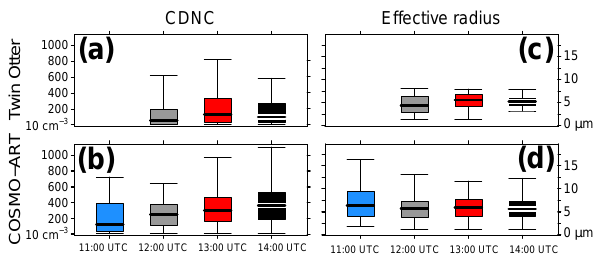
Figure 4. Box plots of (a, b) the CDNC (cm − 3 ) and (c, d) the cloud droplet effective radius (µm) according to the flight track denoted in Fig. 3a for (a, c) Twin Otter observations and the (b, d) COSMO- ART reference case. The flight track is separated into hourly time steps from 11:00 to 14:00UTC as highlighted by the colors (com- pare to Fig. 3). In (a, c) the observations according to the flight track section with 1s temporal resolution of the CDP device are used. In (b, d) the simulation results of the cube that is spanned horizon- tally by the rectangles in Fig. 3a and vertically about 2.3km (in agreement with the Twin Otter maximum flight altitude) are consid- ered. The whiskers capture data from the 0.025 to the 0.975 quantile (95% of the data). Data outside this range are not shown. CDNC values below 10cm − 3 were omitted, leading to an observational data basis of 34, 443, 403 and 115 observations at 11:00, 12:00, 13:00 and 14:00UTC, respectively. Due to the low observational data coverage 11:00UTC is